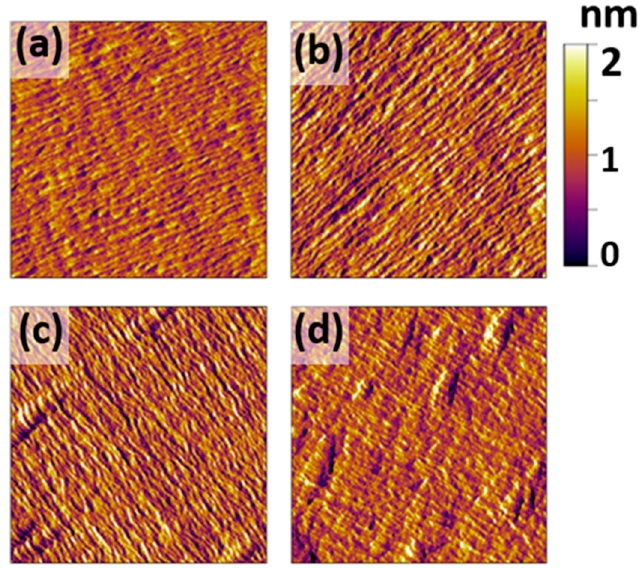
Figure 2. AFM amplitude images of 5 × 5 µm for InGaN grown with various superlattice (SL) compositions with a Cp 2 Mg flow of 36 nmol/min: ( a ) 2 nm InGaN/2 nm GaN (In = 11.1%), ( b ) 2 nm InGaN/1.4 nm GaN (In = 12.6%), ( c ) 2 nm InGaN/0.7 nm GaN (14.2%), ( d ) all InGaN, no SL (21.1%). Note that image ( d ) was taken in the area between the hexagonal surface hillocks.